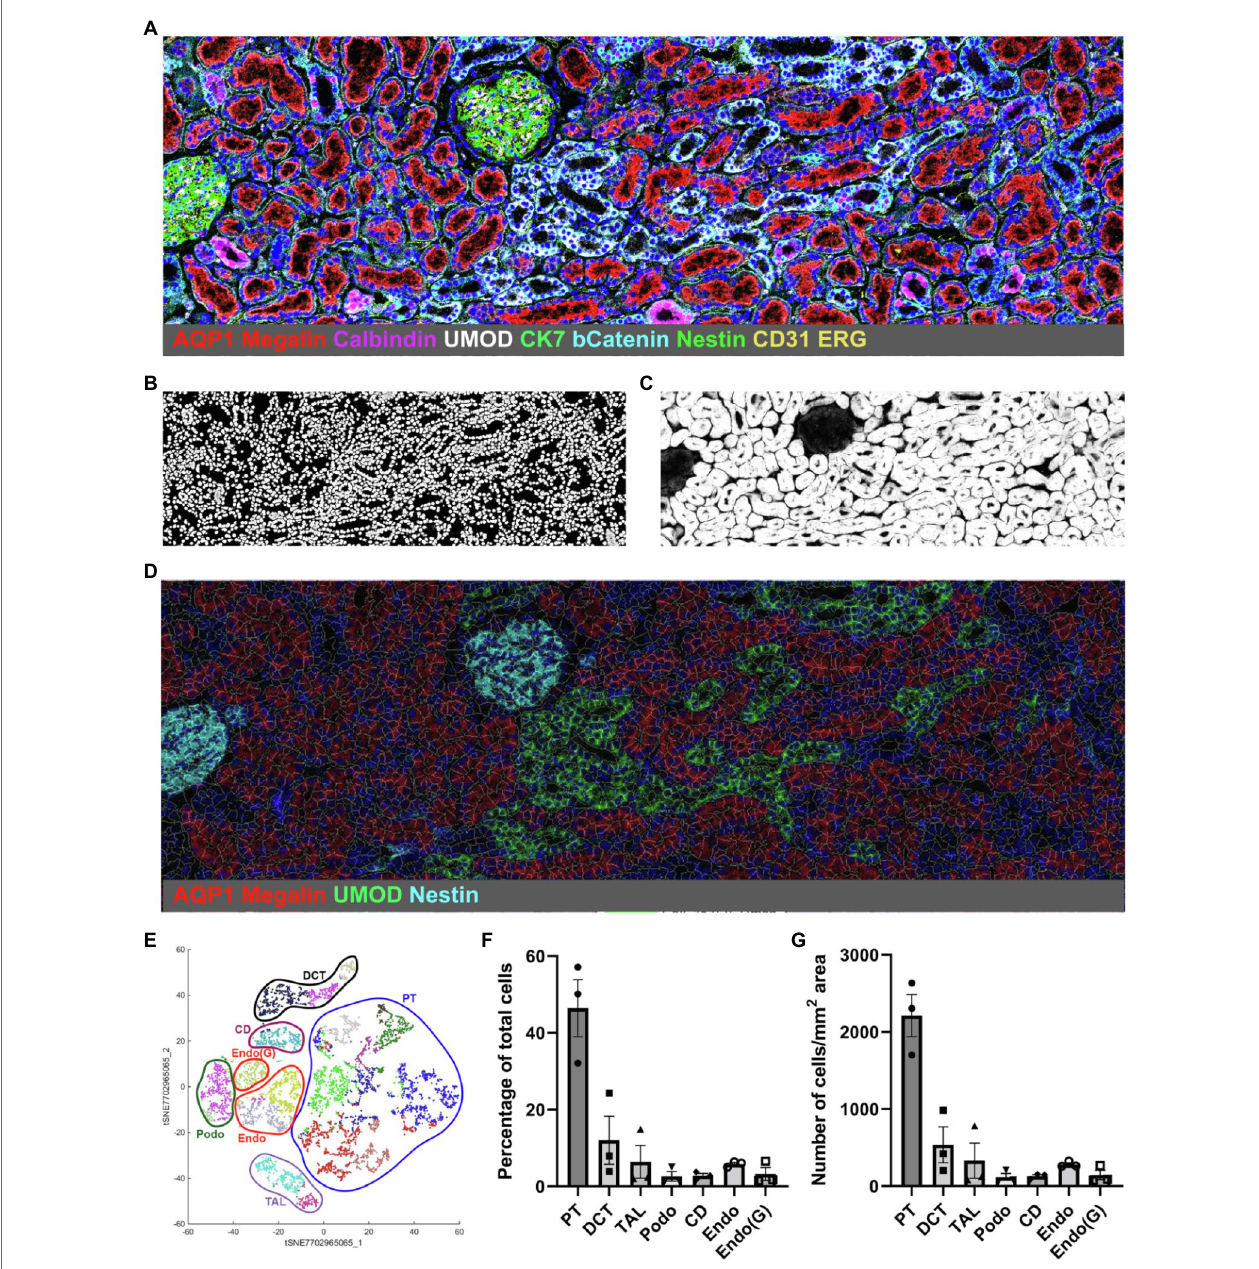
FIGURE 1 | Representative Kidney-MAPPS analysis of healthy human kidney tissue for identification of resident cell populations. (A) Pseudocolored image of a region of interest analyzed by IMC. The depicted colors correspond to the markers listed on the image. AQP1, aquaporin-1; UMOD, uromodulin; bCatenin, β -Catenin; CK7, cytokeratin-7; and ERG, ETS-related gene. (B,C) Probability images for nuclei (B) and tubular cells (C) , created using the Ilastik software. (D) Segmentation mask generated in CellProfiler overlaid on a pseudocolored image created in HistoCAT. Highlighted markers were selected in order to represent the tissue structure analogous to (A) while allowing visibility of the cell segmentation. (E) tSNE plot showing different cell types/clusters identified through PhenoGraph analysis of three representative healthy kidney samples in HistoCAT. PT, proximal tubule; DCT, distal convoluted tubule; TAL, thick ascending limb; Podo, podocytes; CD, collecting duct; Endo, endothelial cells (non-glomerular); and Endo(G), glomerular endothelial cells. (F,G) Quantification of the cell types identified in (E) as a percentage of the total number of cells (F) and the number of cells per mm 2 area (G) . Bars show the mean ± SD. n =